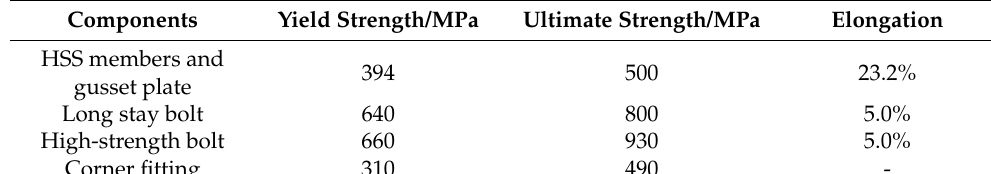
Figure 6. Design and results of material property test: ( a ) the nominal size of coupon specimen; ( b ) stress-strain curve.